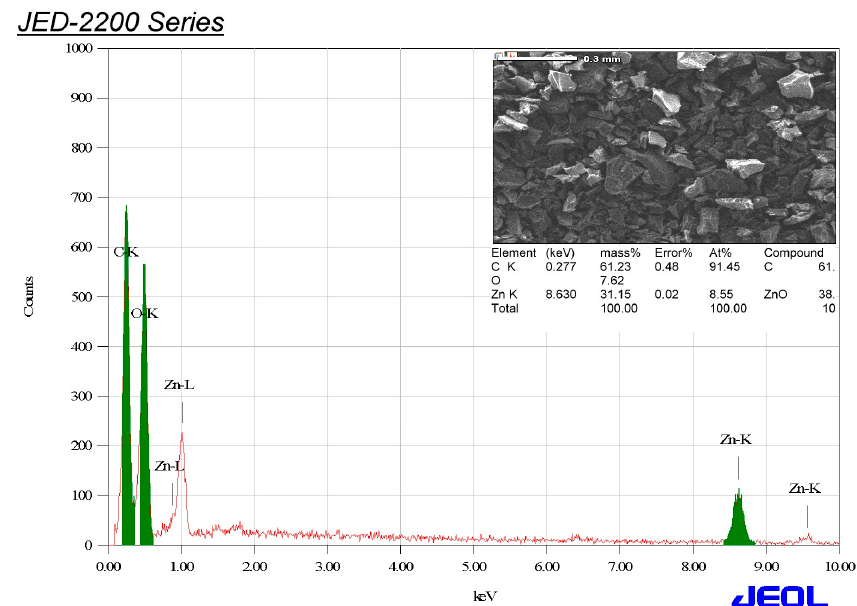
Figure 7. EDX spectrum of ZnO-NPs.